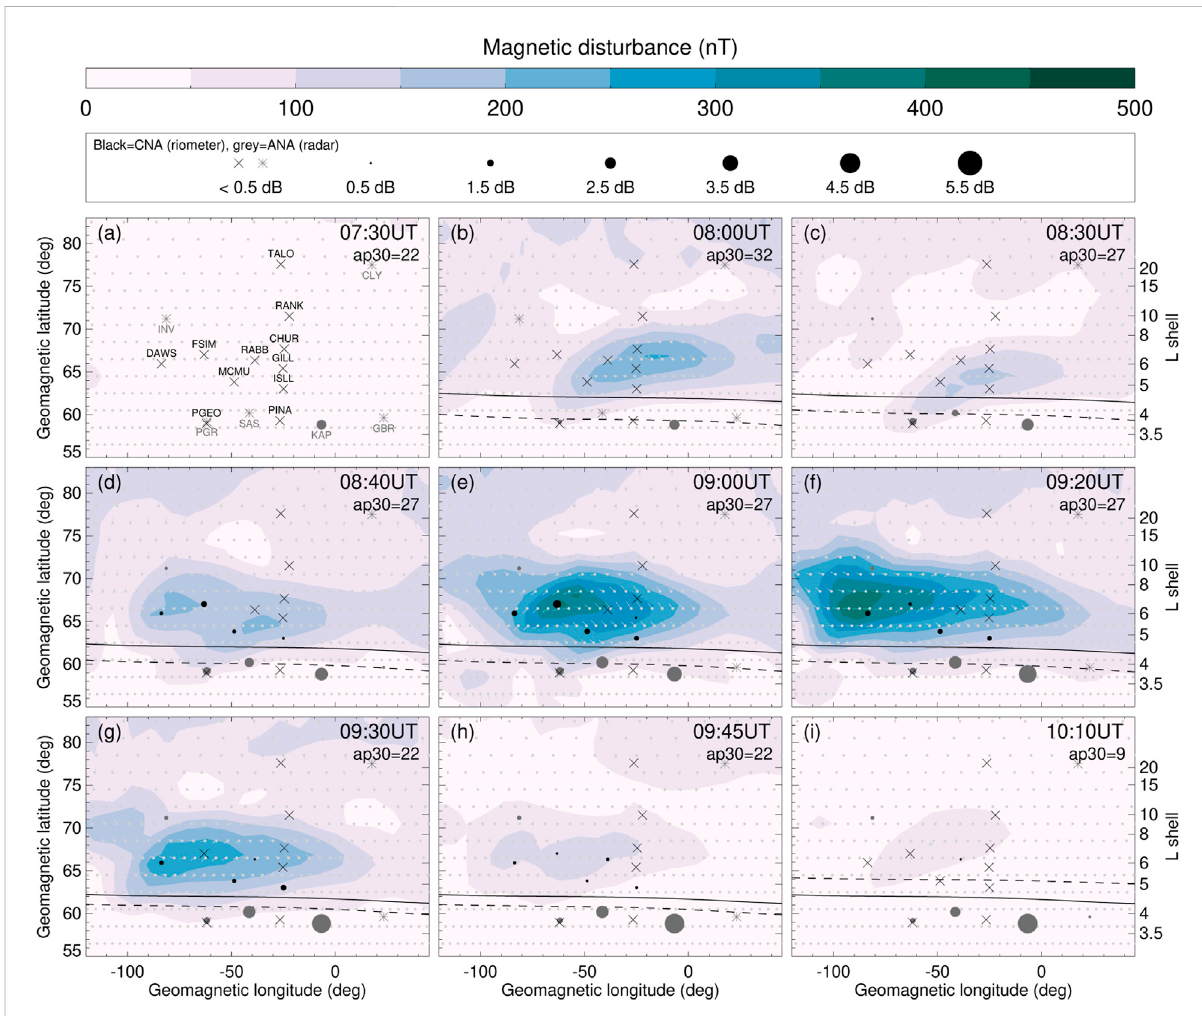
FIGURE 9 Spatial evolution ofthemagnetic fi eld disturbance,30 MHz cosmic noise absorption and 10 – 11 MHz atmosphericnoise attenuationduring the substorm event on 18 June